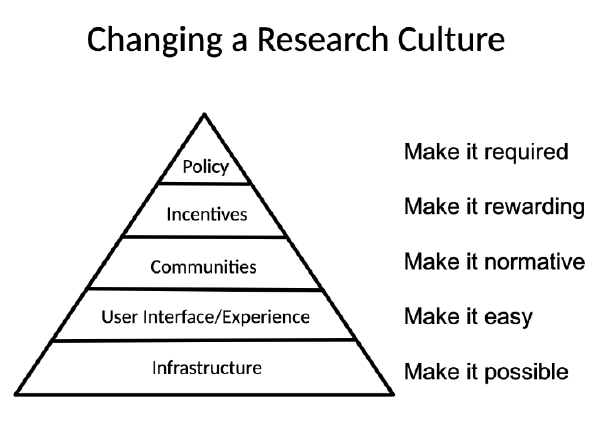
Figure 2 Strategy for culture and behavior